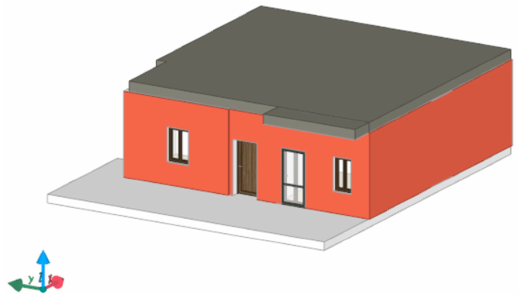
Figure 1. 3D building simulation.